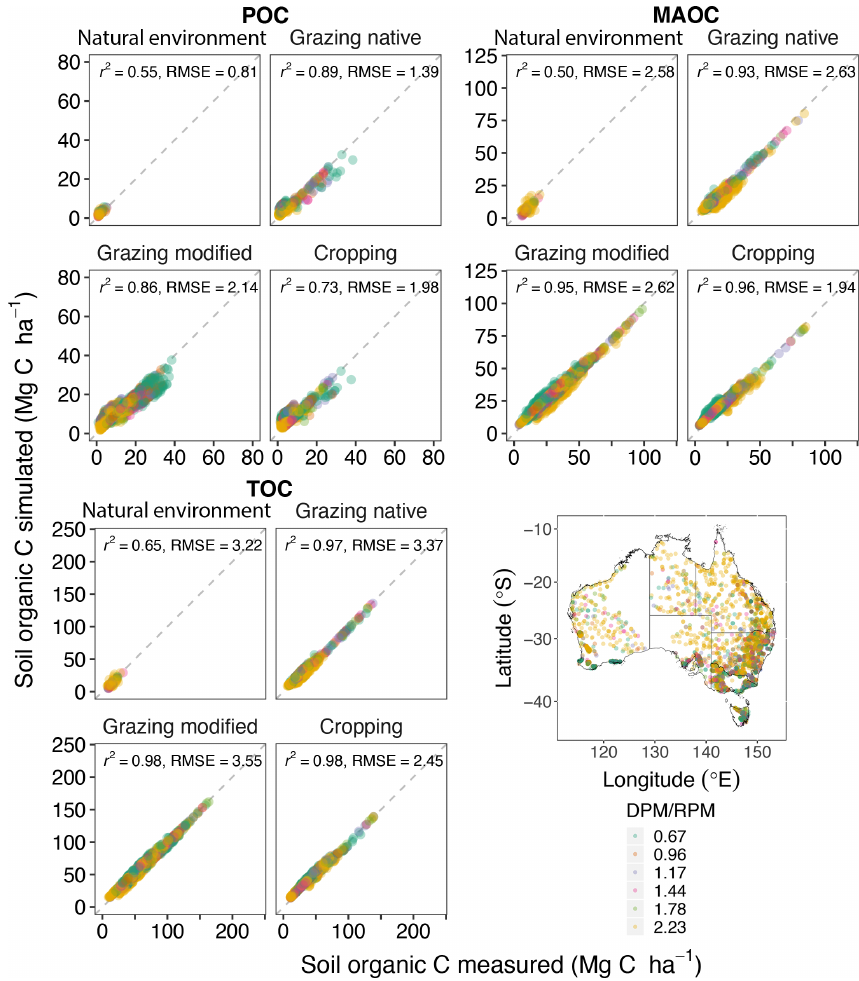
Figure 3. Simulation of equilibrium soil organic C levels after optimisation, based on its sensitivity to the changes in the allocation of incoming plant and manure C into the decomposable plant material (DPM) and resistant plant material (RPM) components ( n = 4043). The map shows the geographic distribution of DPM/RPM values, where high values correspond to faster